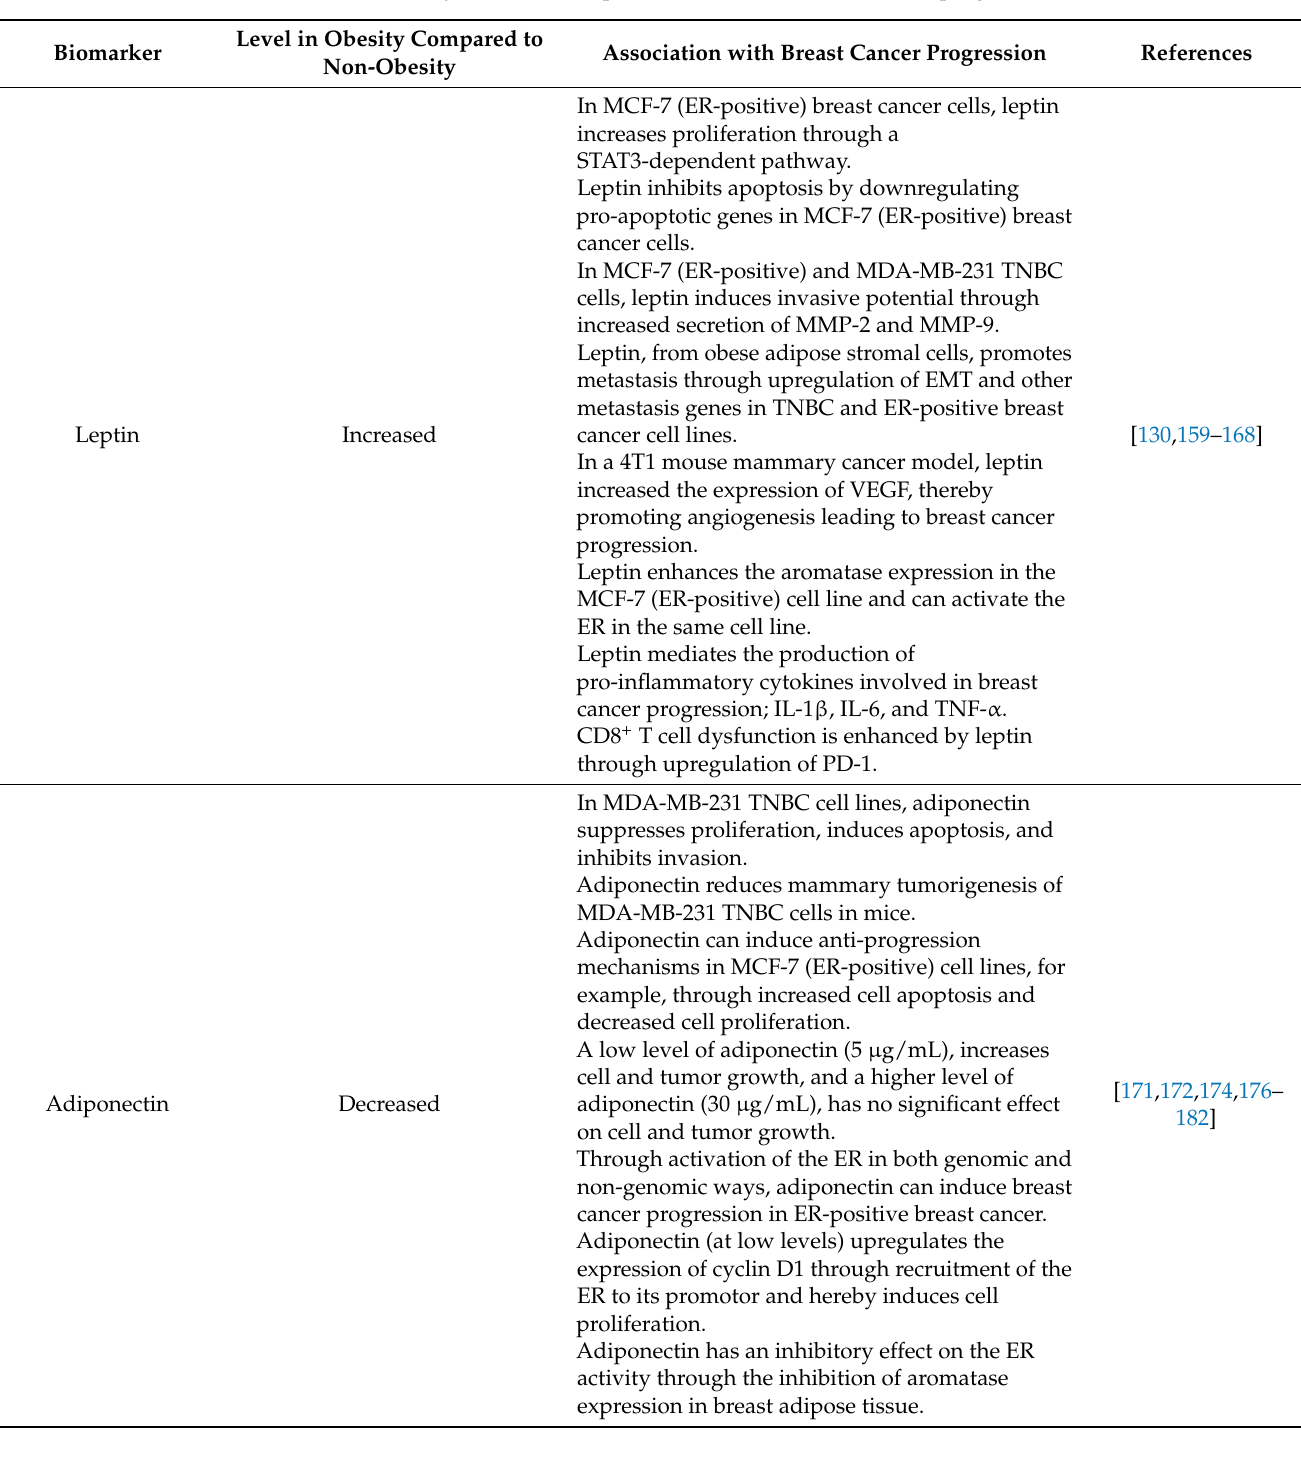
Table 3. Local obesity-associated adipokines involved in breast cancer